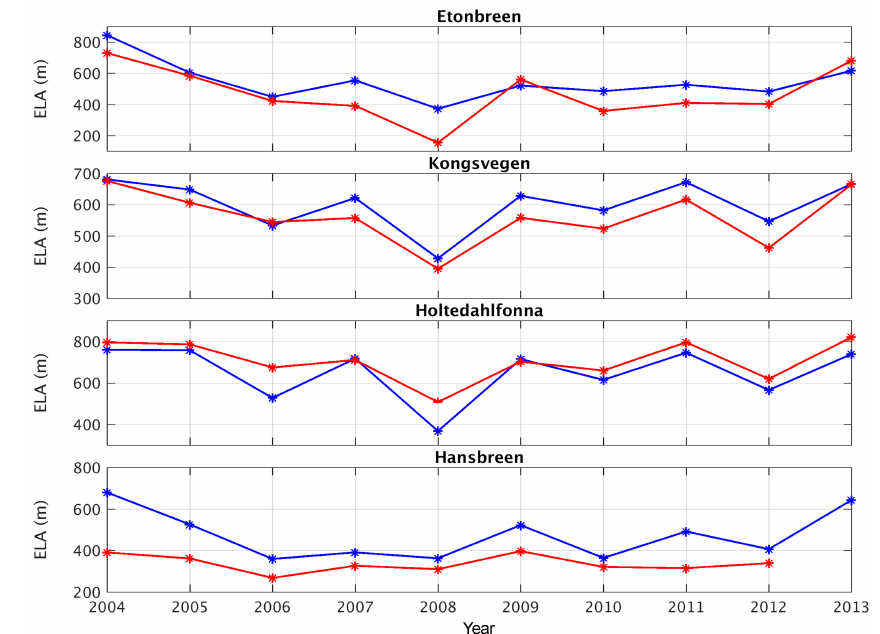
Figure 4. Estimated ELA from WRF-CMB (blue) and stakes (red) at the four main validation glaciers.